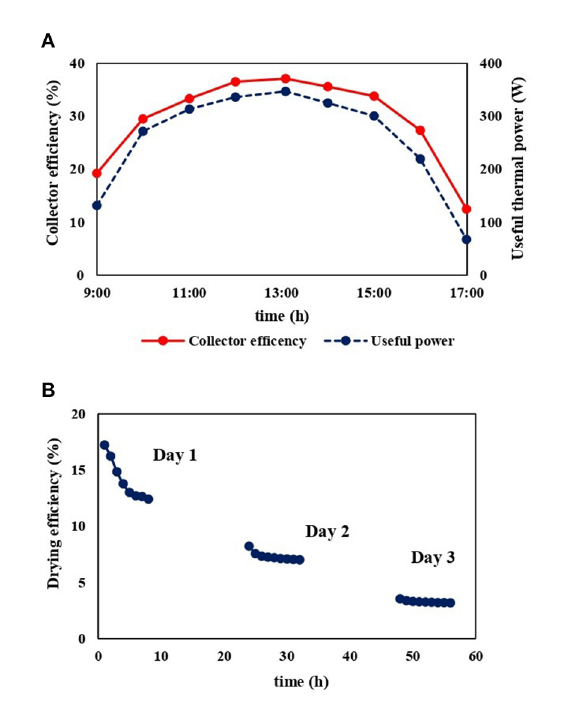
FIGURE11 (A) Daily variation of the instantaneous collector efficiency and useful thermal power for the solar drying unit and (B) variation of the drying efficiency of the solar dryer as a function of time for a total curing duration of 3